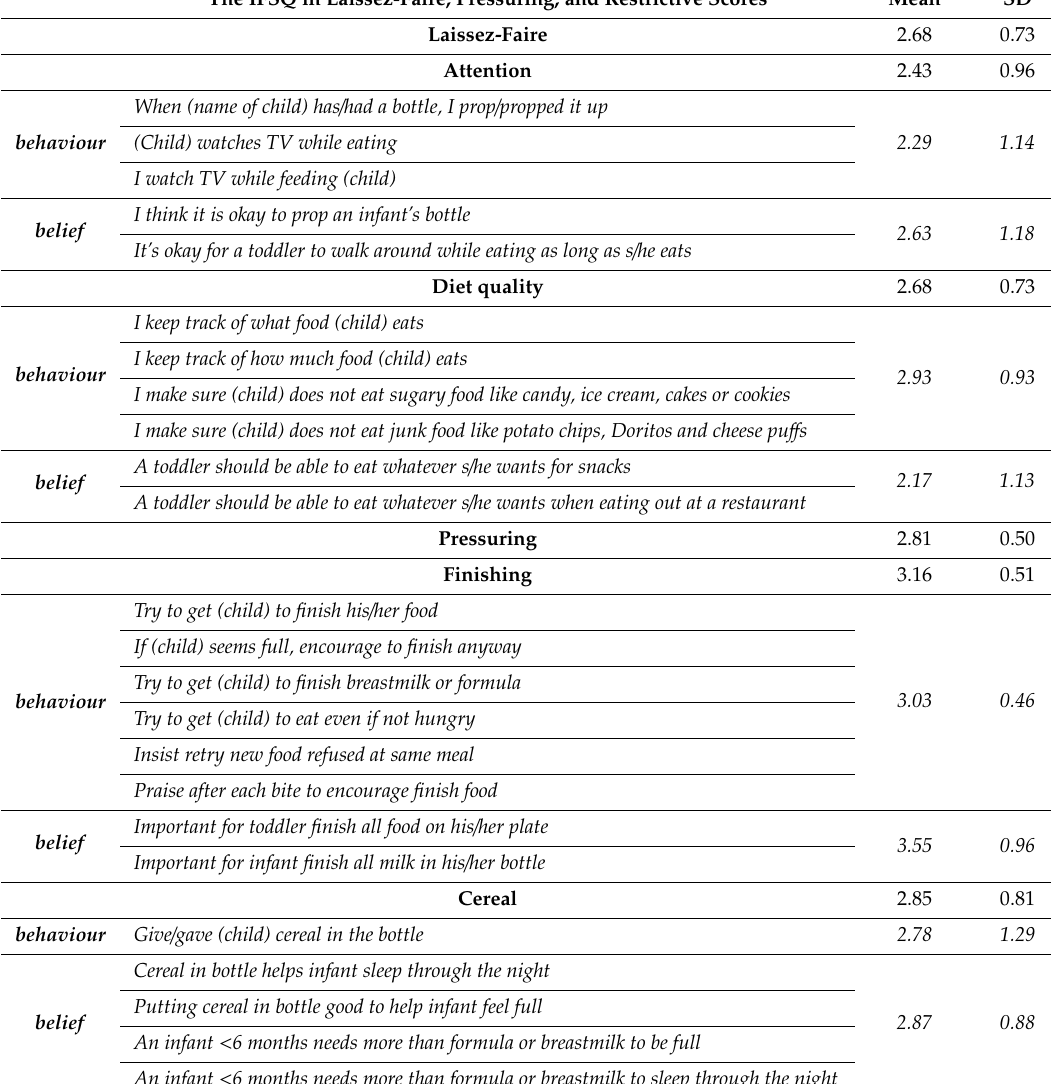
Table 1. IFSQ in laissez-faire, pressuring, and restrictive scores ( n = 32). The IFSQ in Laissez-Faire, Pressuring, and Restrictive Scores Mean SD Laissez-Faire 2.68 0.73 Attention 2.43